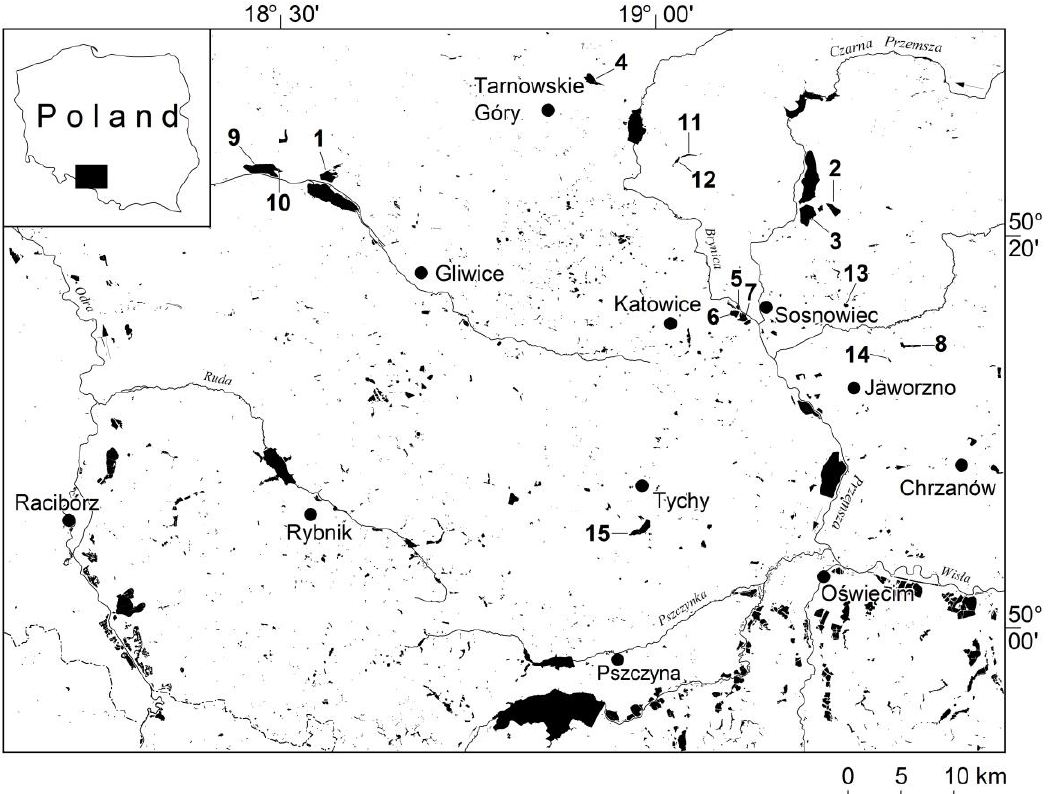
Figure 1. Locations of the water bodies used for recreational purposes covered by the study in the Silesian Upland and its periphery: 1 —Dzierżno Małe, 2— Pogoria I, 3 — Pogoria III, 4 —Chechło,